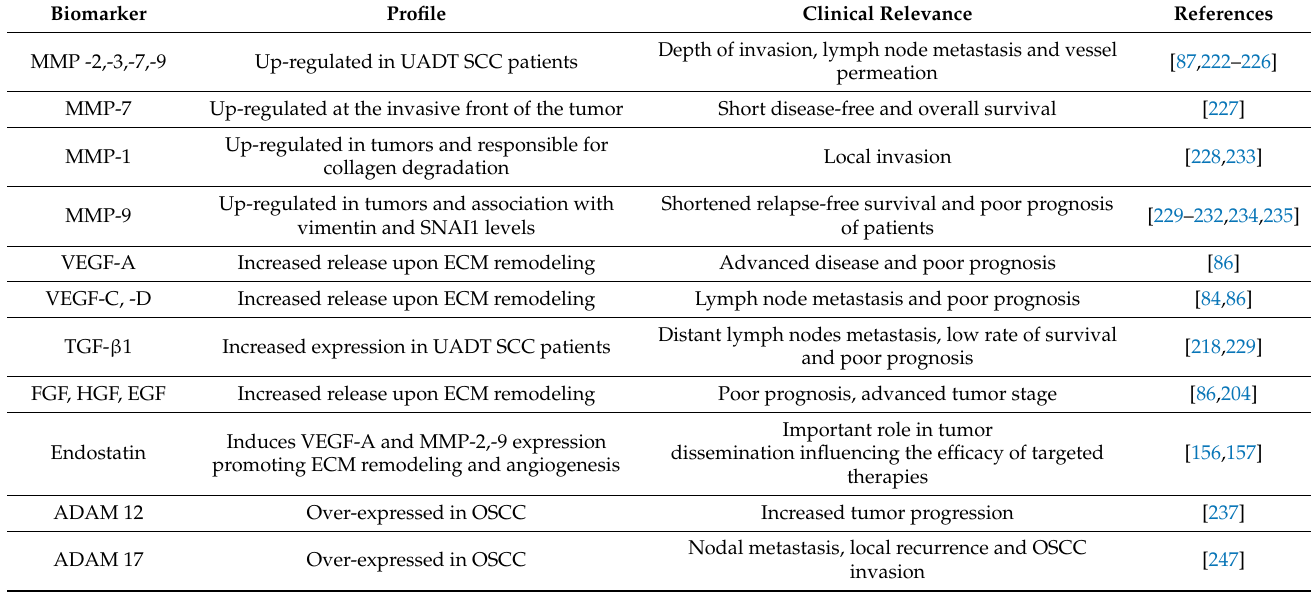
Table 2. List of valuable non-ECM biomarkers for UADT SCC detection and their clinical